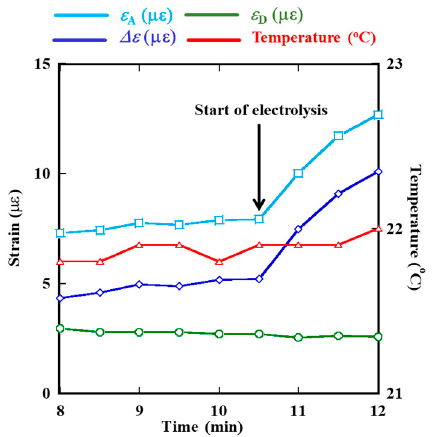
Figure 10. Close-up of Figure 9 around the start of the electrolysis process. To investigate the accuracy of the amplifier circuit under the active-dummy method, the actual thickness reduction of the test piece was measured. ∆ y A is the change in thickness of the test piece, as determined by measuring the actual thickness at five different points on the corroded area of the test